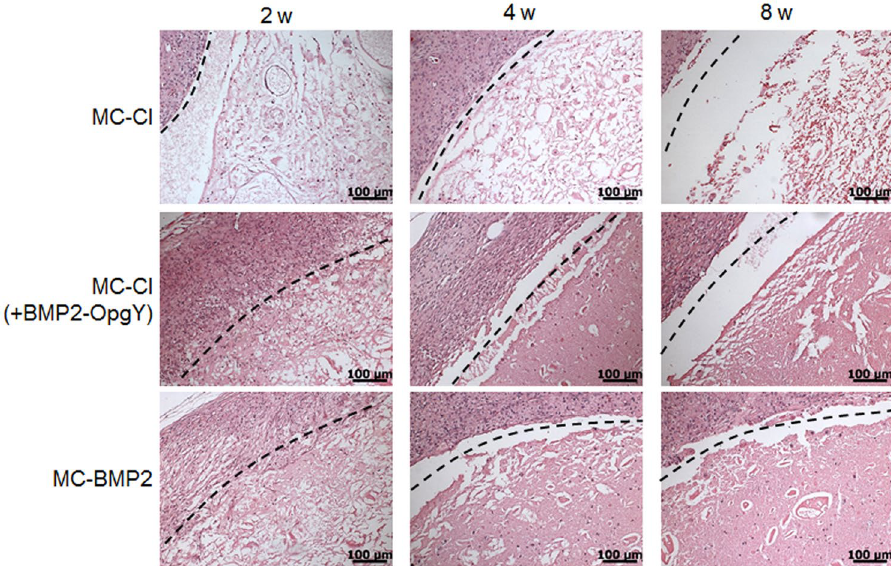
Figure 8. Hematoxylin and eosin-stained histological sections of engineered bone from mice implanted with human periodontal ligament stem cells on MC-Cl, MC-Cl ( + BMP2-OpgY), or MC-BMP2 hydrogels removed after 2, 4, or 8 weeks (magnification 200 × , scale bars represent 100 μ m).